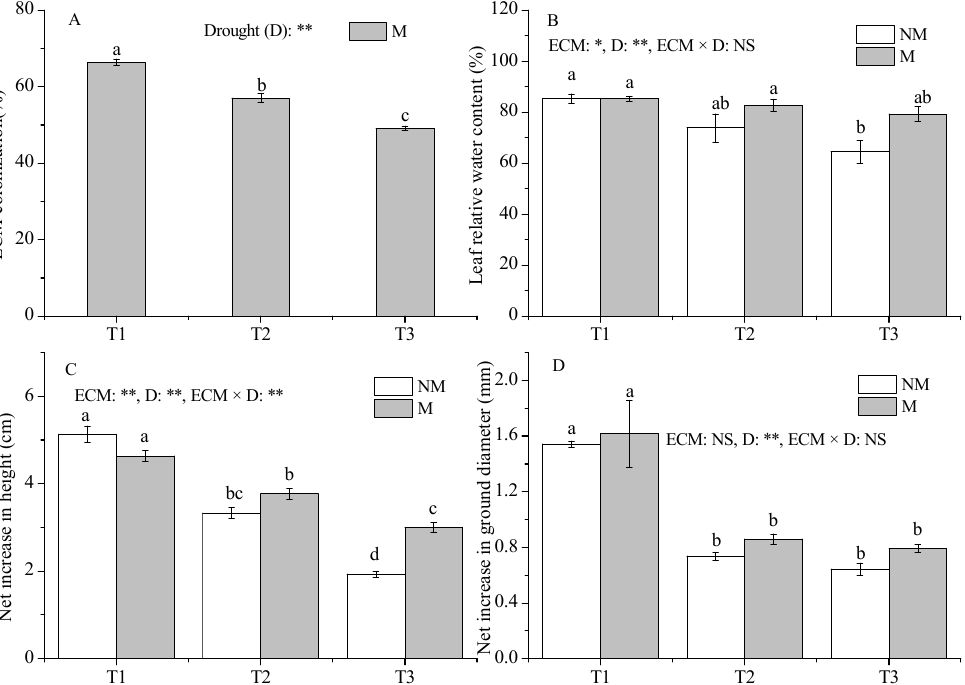
Figure 2. Effect of ECMF and drought on the growth, colonization rate, and water status of P. massoniana . Values (means ± SEs) followed by different letters among treatments indicate significant differences at the 5% level, and the same letter indicates no significant difference. NS, not significant, * p < 0.05; ** p < 0.01. T1, well-watered, T2, moderate drought, and T3, severe drought. NM, no Sl inoculation, M, Sl inoculation. D, drought treatment. The le tt ers denote ( A ) ECMF colonization; ( B ) leaf relative water content; ( C ) net increase in seedlings height; ( D ) net increase in seedlings ground diameter.